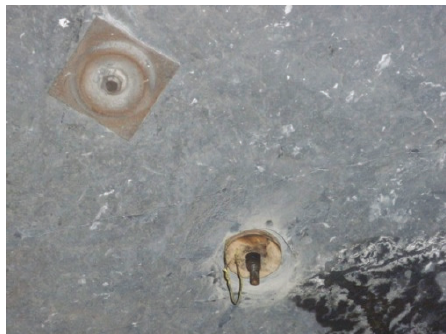
Fig. 4. Signaling device for roofs stratifications (photo by K. Skrzypkowski)